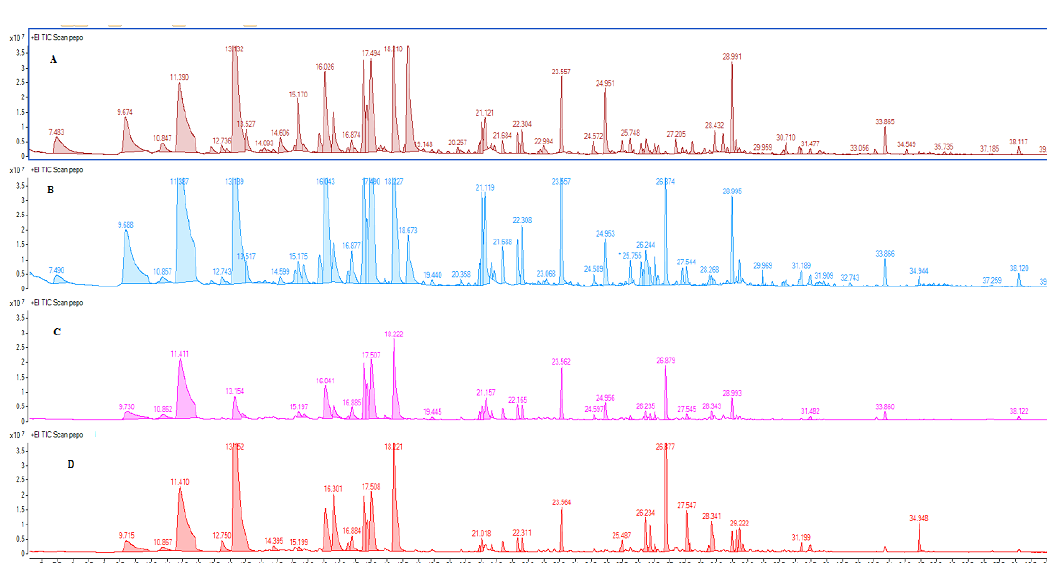
Figure 1. Chromatographic profiles total ion current (TIC) of red Topepo fruits obtained by cultivation: ( A ) without fertilizers (CTR); ( B ) horse dung (HD); ( C ) olive compost (CO); ( D ) vegetable compost (CV).